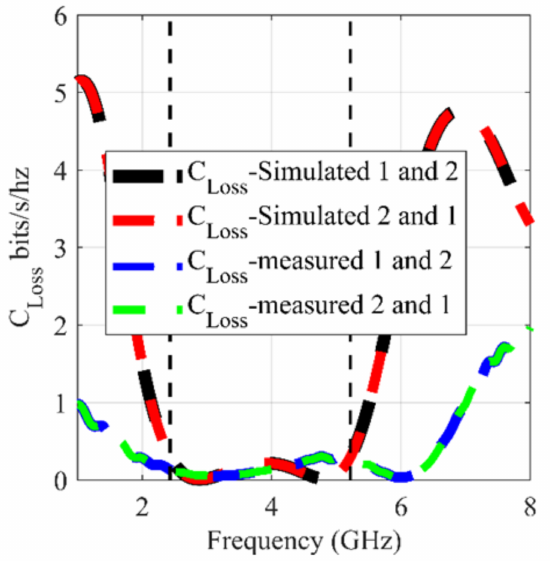
Figure 22. The measured and simulated CCL for mid-band MIMO